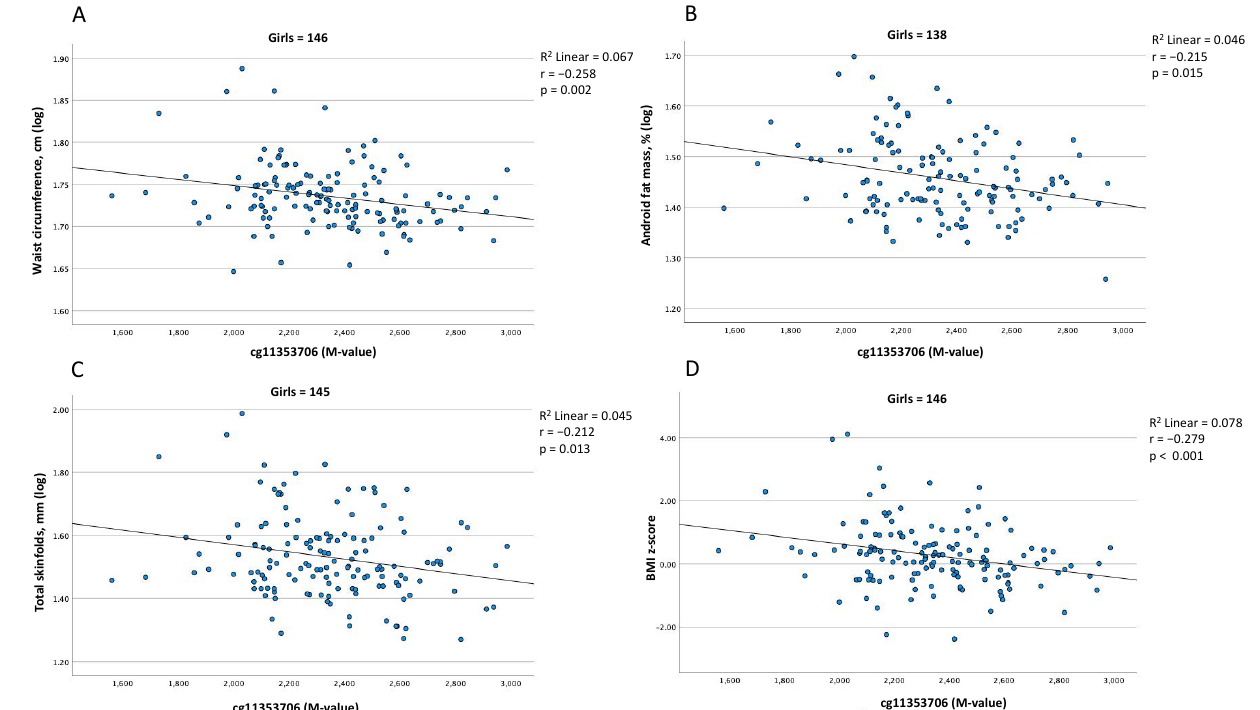
Figure 3. Significant associations between blood cell DNAm levels at the SERPINE1 gene locus and adiposity levels at 5 years of age, in girls. Associations between DNAm levels at cg11353706 and ( A ) waist circumference, ( B ) android percentage of fat mass, ( C ) total skinfold thickness, and ( D ) BMI z-score. Partial Pearson’s correlations, adjusted for age, batch effect, and cell-type heterogeneity, were considered statistically significant at p < 0.017 after Bonferroni correction for multiple testing (i.e., three independent groups of adiposity markers). Abbreviations: BMI, body mass index.